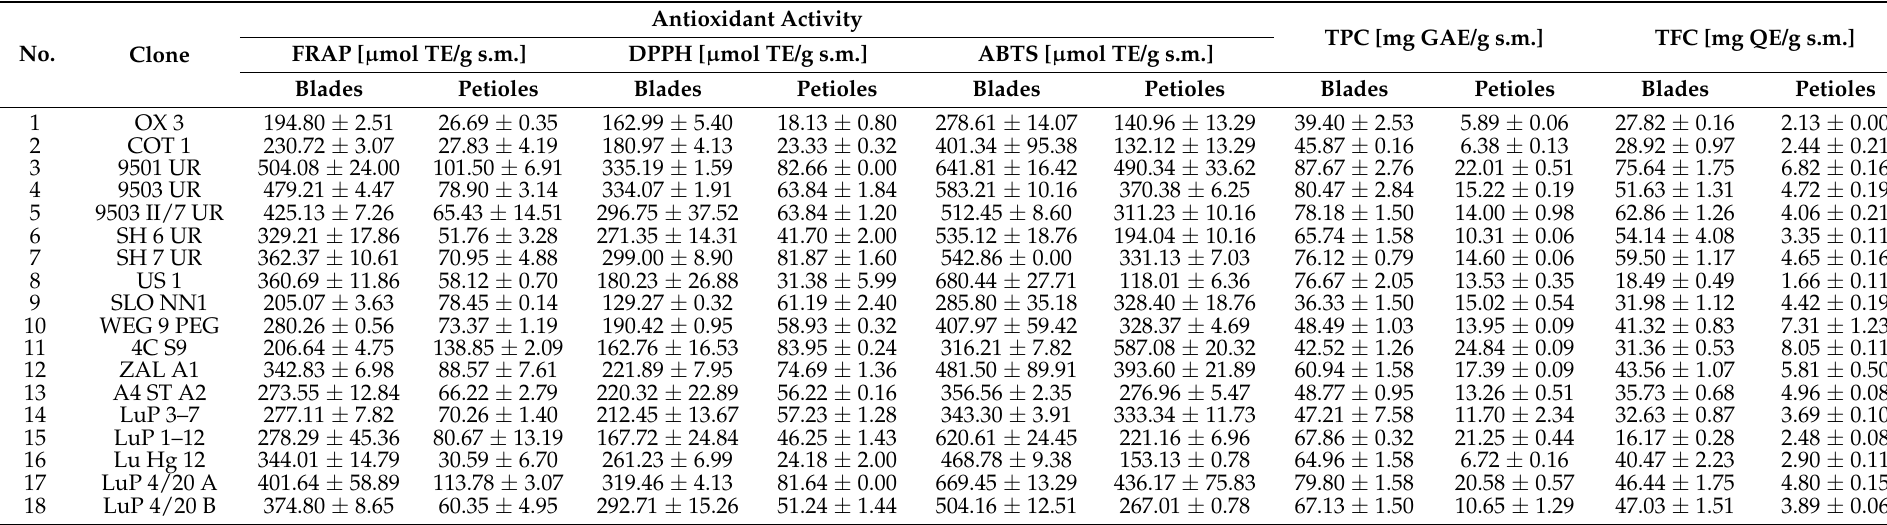
Table 2. Antioxidant activity, total phenolics and flavonoids contents of Paulownia spp. leaf (separately blades and petioles) grouped by species: P. elongata × P. fortunei (no. 1–2) P. tomentosa × P. fortunei (no. 3–7), P. tomentosa (no. 8–18).